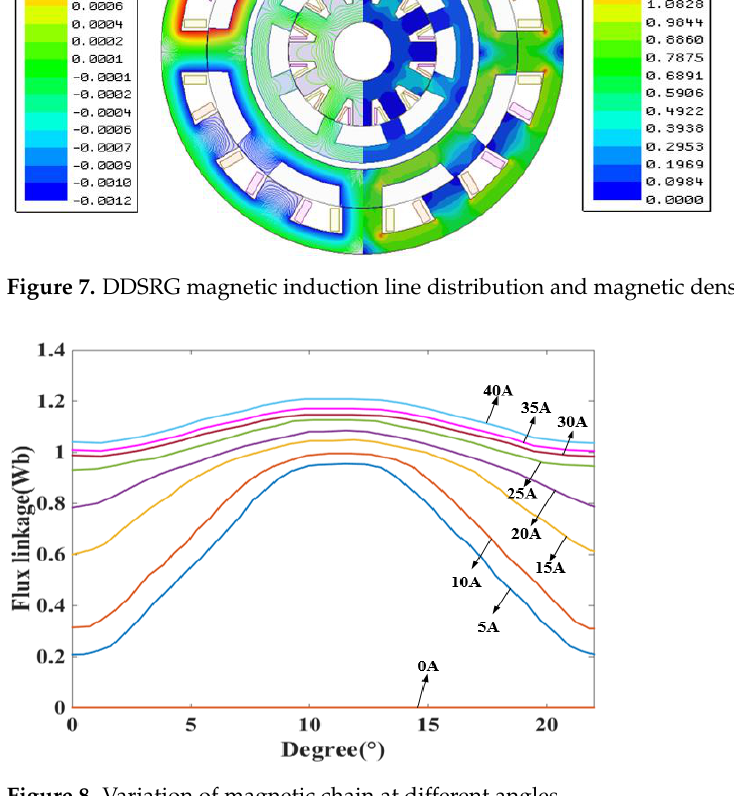
( b ) Figure 9. Radial magnetic density of the air-gap space inside the outer air gap of DDSRG. ( a ) Mag- netic density waveform diagram. ( b ) Harmonic decomposition. In order to see the radial variation of the DDSRG air-gap magnetic density more clearly, taking the outer air-gap as an example, Figure 10 shows the DDSRG outer air-gap radial magnetic density – rotor position – time waveform. It can be observed along the spatial axis that when a phase is excited, four corresponding radial component peaks appear. Observed along the time axis, 12 peaks appear in one excitation cycle, indicating alternating operation of the three phases, which is in accordance with the generator stator structure characteristics. As shown in Figure 11 for the air-gap time characteristics of the DDSRG and the time domain decomposition spectrum obtained by FFT, the poles appear mainly at a time order of 8 N ( N = 0, 1, 2…)Hz.